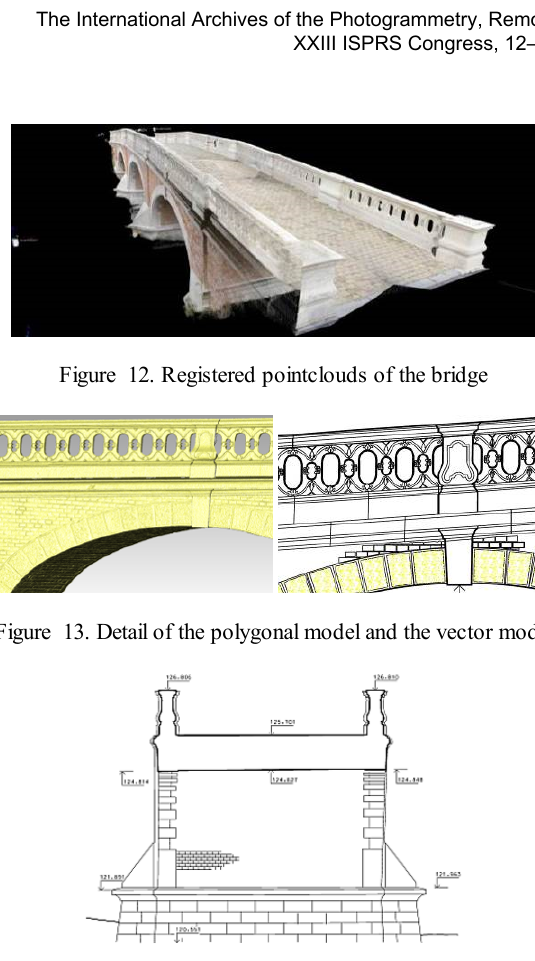
Figure 14. Cross section view of the bridge